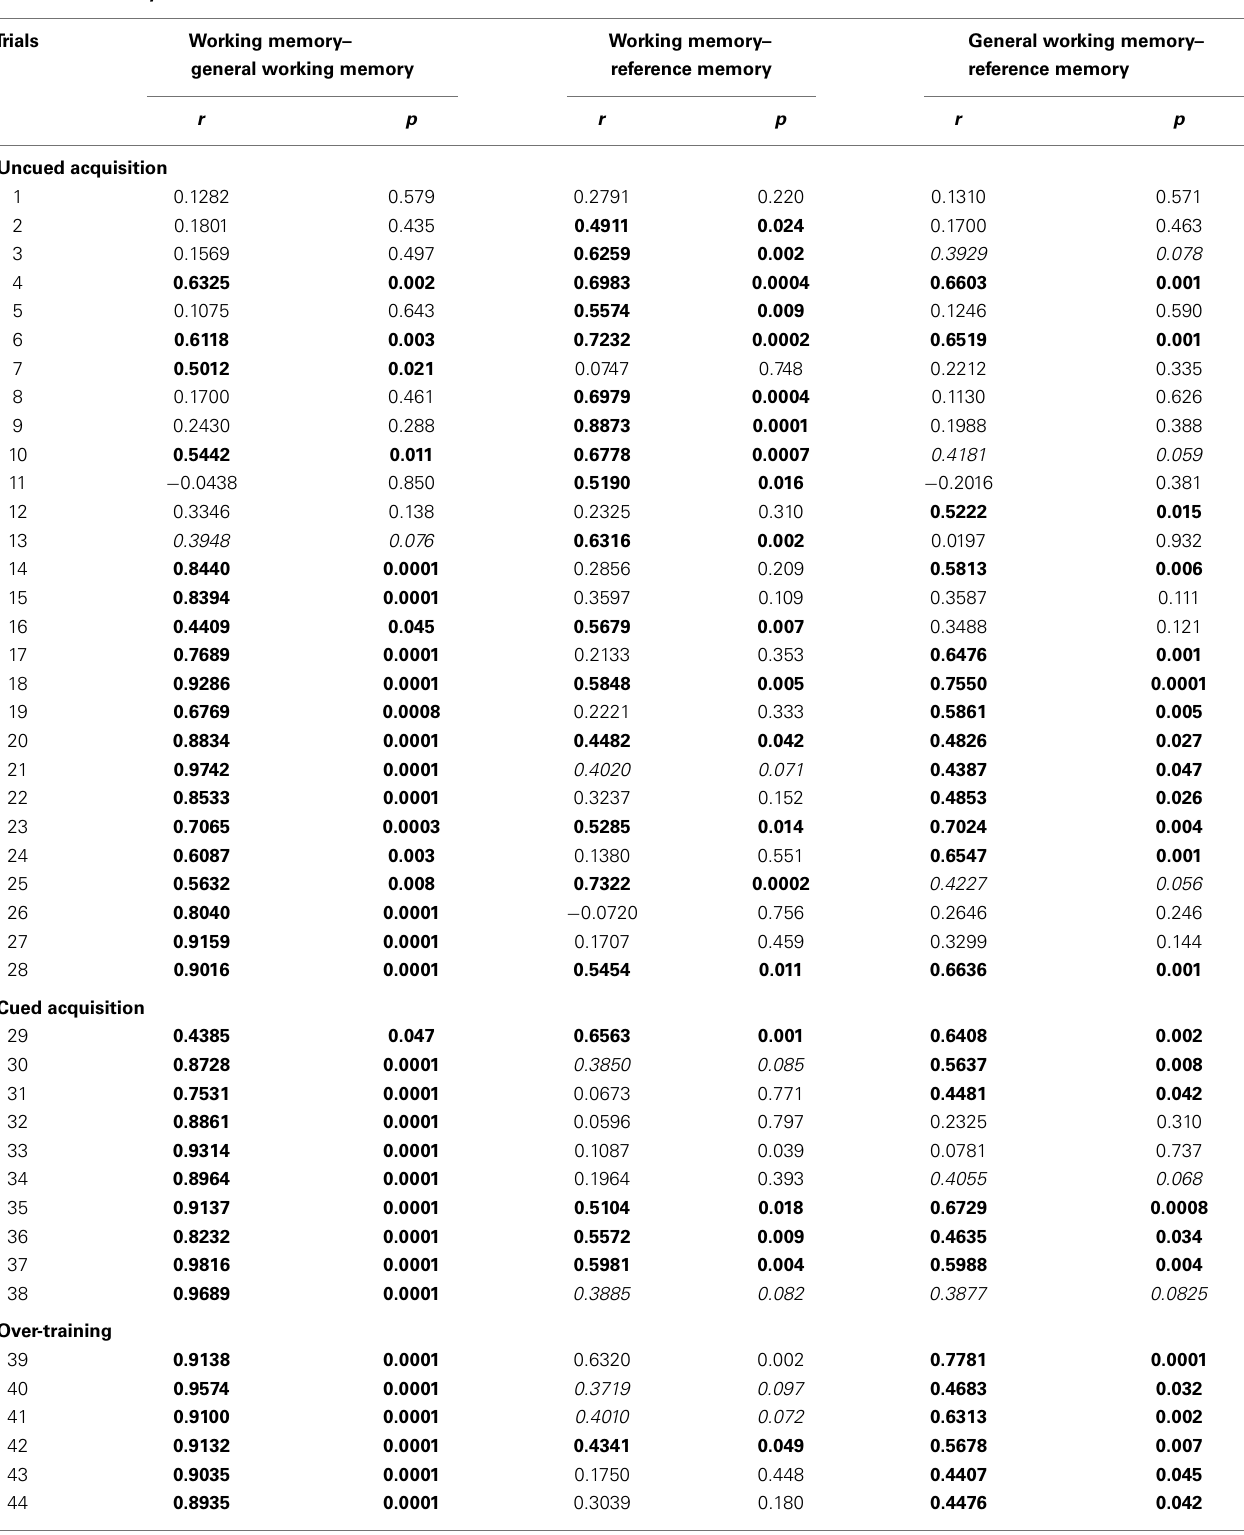
Table 3 | Pearson correlation coefficients and associated p -values for correlations between working memory, general working memory, and reference memory